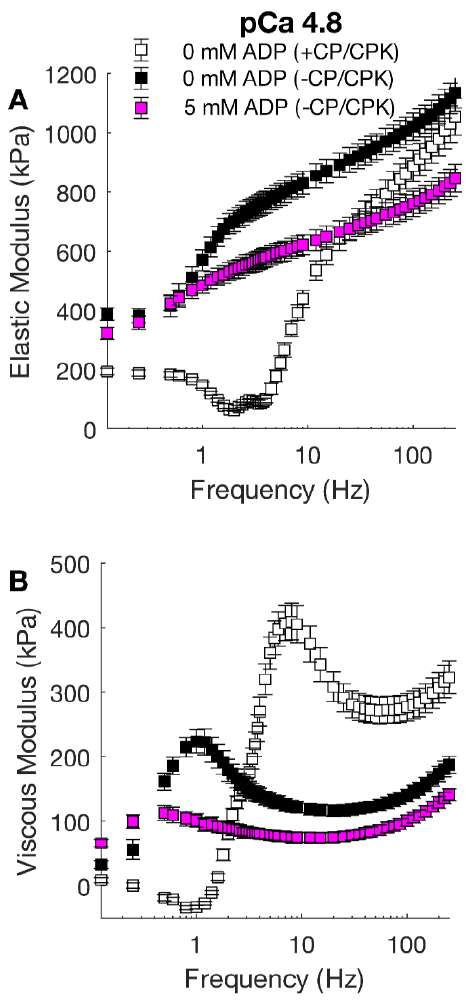
Figure 7. Viscoelastic myocardial stiffness at maximal Ca 2+ -activation. ( A ) Elastic and ( B ) viscous modulus values were plotted against frequency for 0 and 5 mM [ADP] in the presence and absence of CP and CPK at pCa 4.8. Nested two-way linear mixed models analysis was used to assess main effects of frequency, treatment group ([ADP] ± CP/CPK) and the frequency * treatment group interaction. In both panels there was a main effect of frequency ( p < 0.001), treatment ( p < 0.001), and their interaction ( p < 0.001) . Within both panels Fisher’s LSD post hoc analysis indicated all treatment groups were significantly different from each other at a single frequency ( p < 0.05, where obviously different) except at intercept points where moduli values cross over each other. n fibers were 13 for 0 mM ADP (+CP/CPK), 12 for 0 mM ADP (+CP/CPK), and 11 for 5 mM ADP (+CP/CPK), from 2 hearts.